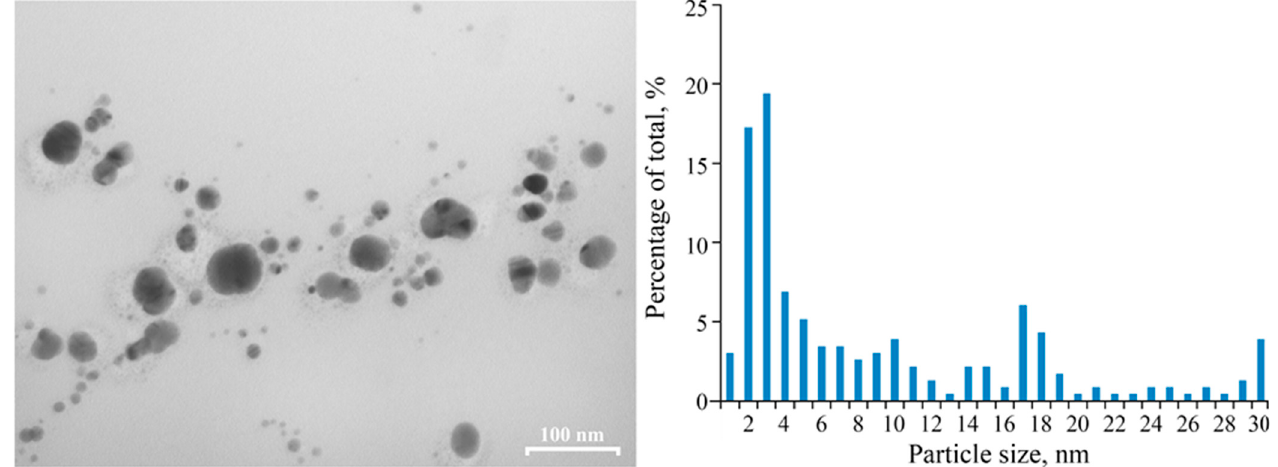
Figure 7. TEM image of the PAAg that was stored as aqueous solution for one year and size distributions of nanoparticles.